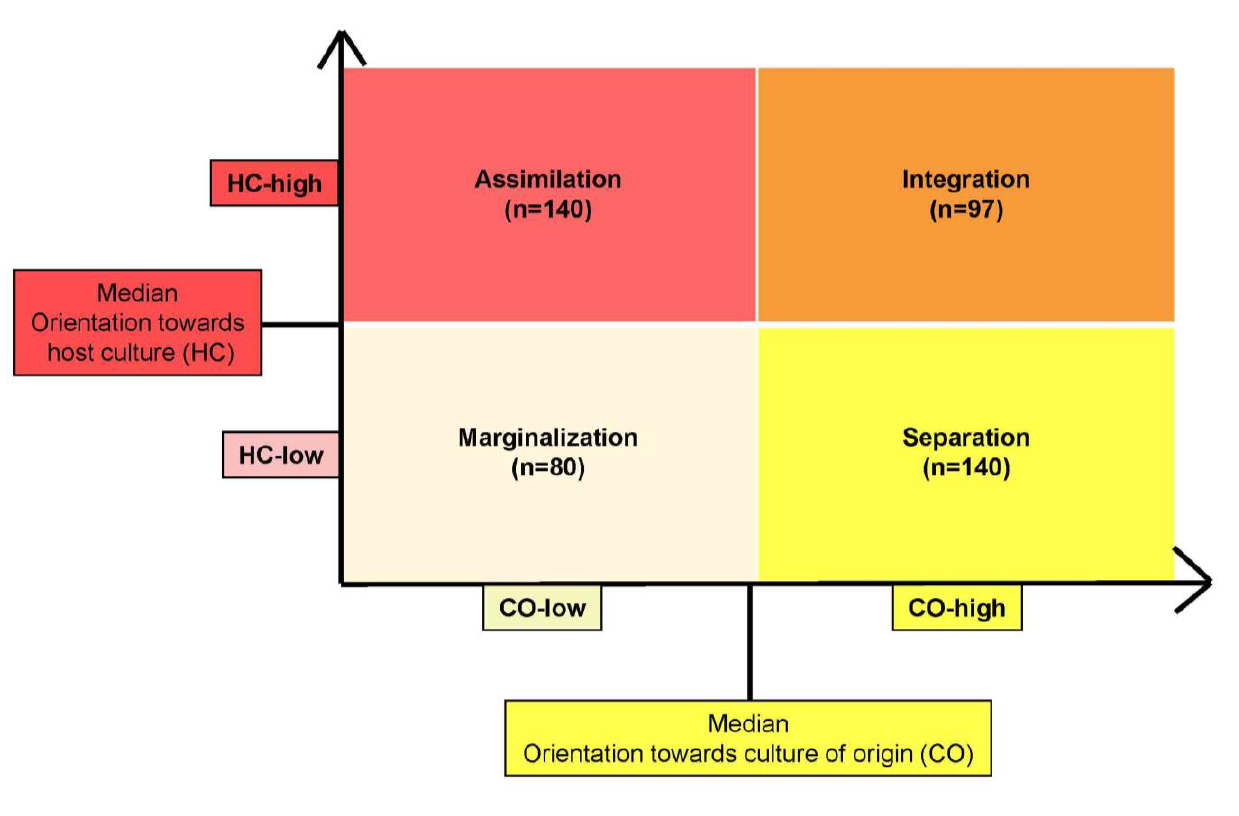
Figure 1. Distribution of the study population in the acculturation strategies based on the model of Berry